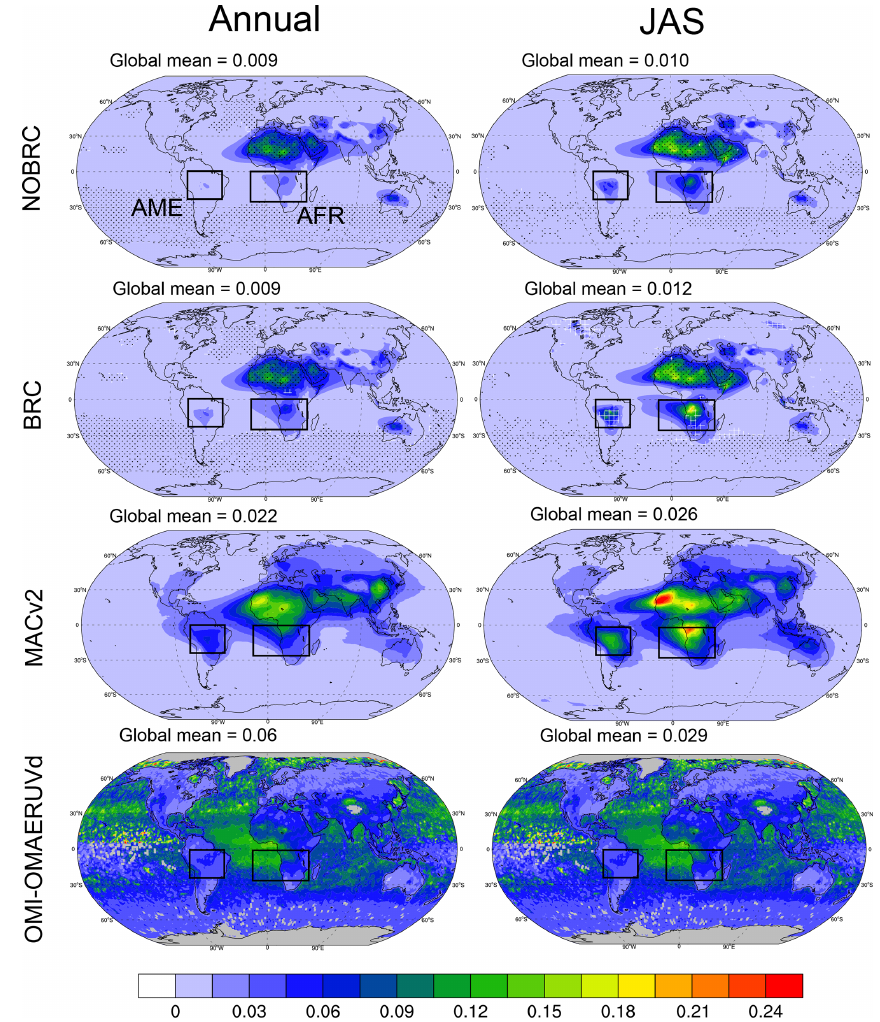
Figure 10. Same as Fig. 8 but for the AAOD (350nm; see Tables 2 and 3 for details).